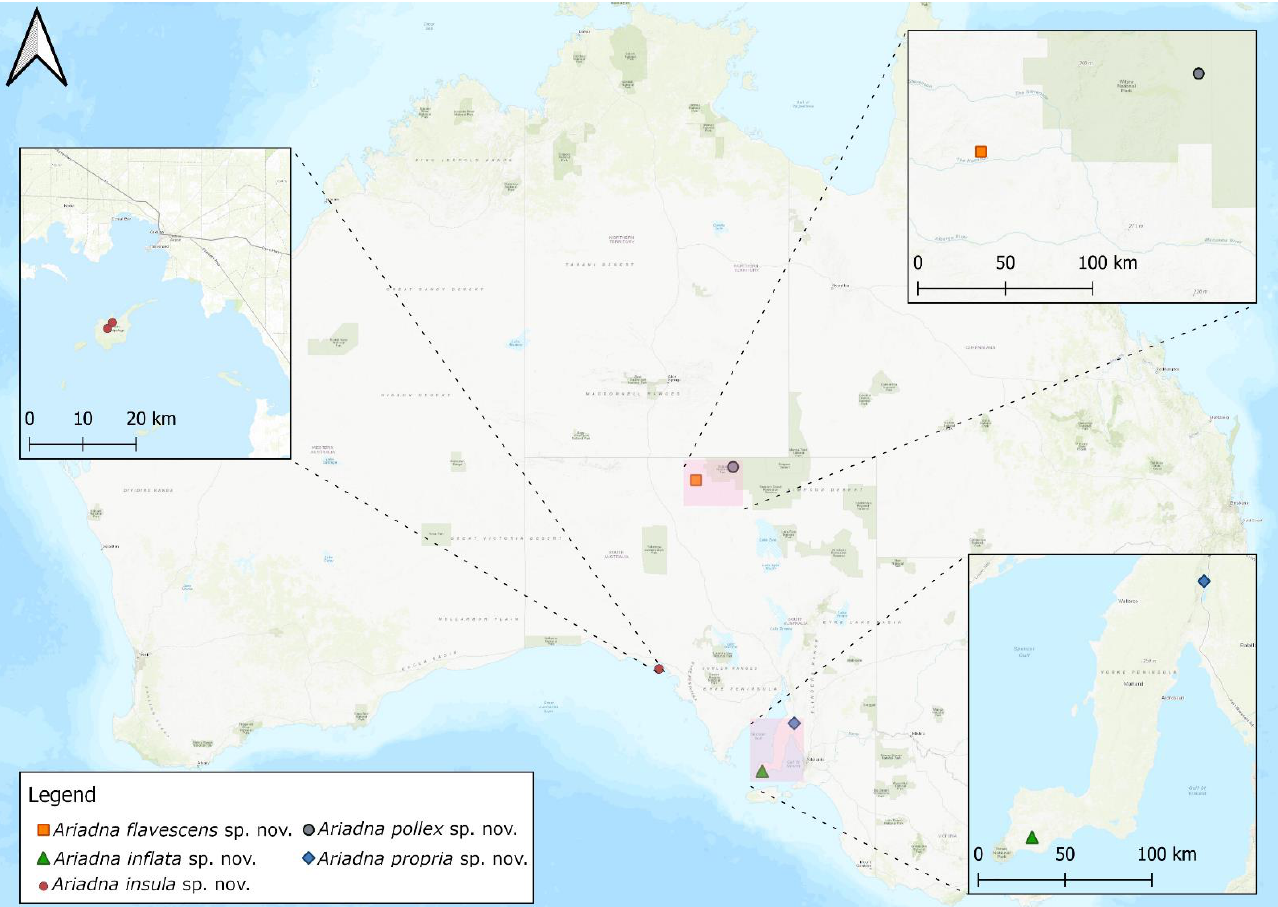
Figure 39. Map showing the currently known distribution of A. flavescens sp. nov.: A. inflata sp. nov. , A. insula sp. nov. A. pollex sp. nov. and A. propria sp. nov